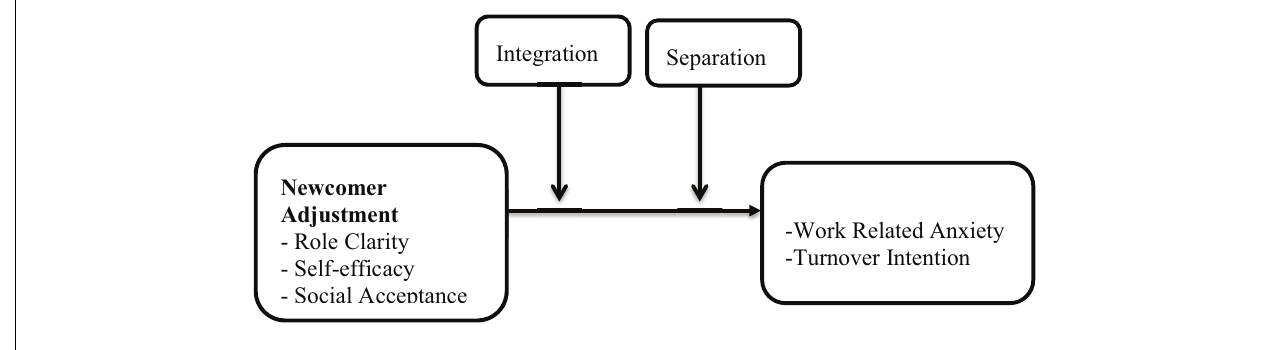
FIGURE 1 | Proposed model of the